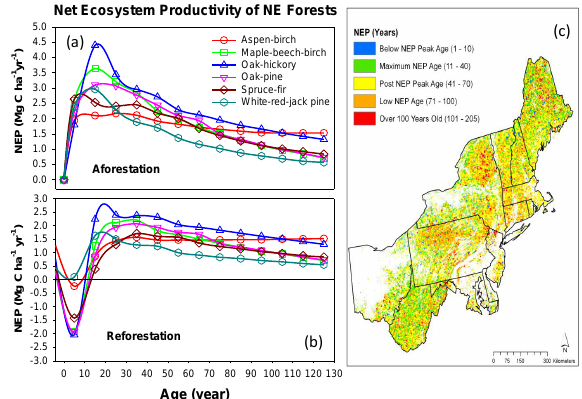
Figure 7. Average Net Primary Production (gC m -2 yr -1 ) of the US Northeastern forests and the variation inherited from the age deviation. Fig. 7. Average Net Ecosystem Production (gCm − 2 yr − 1 ) of the US Northeastern forests and the variation inherited from the age